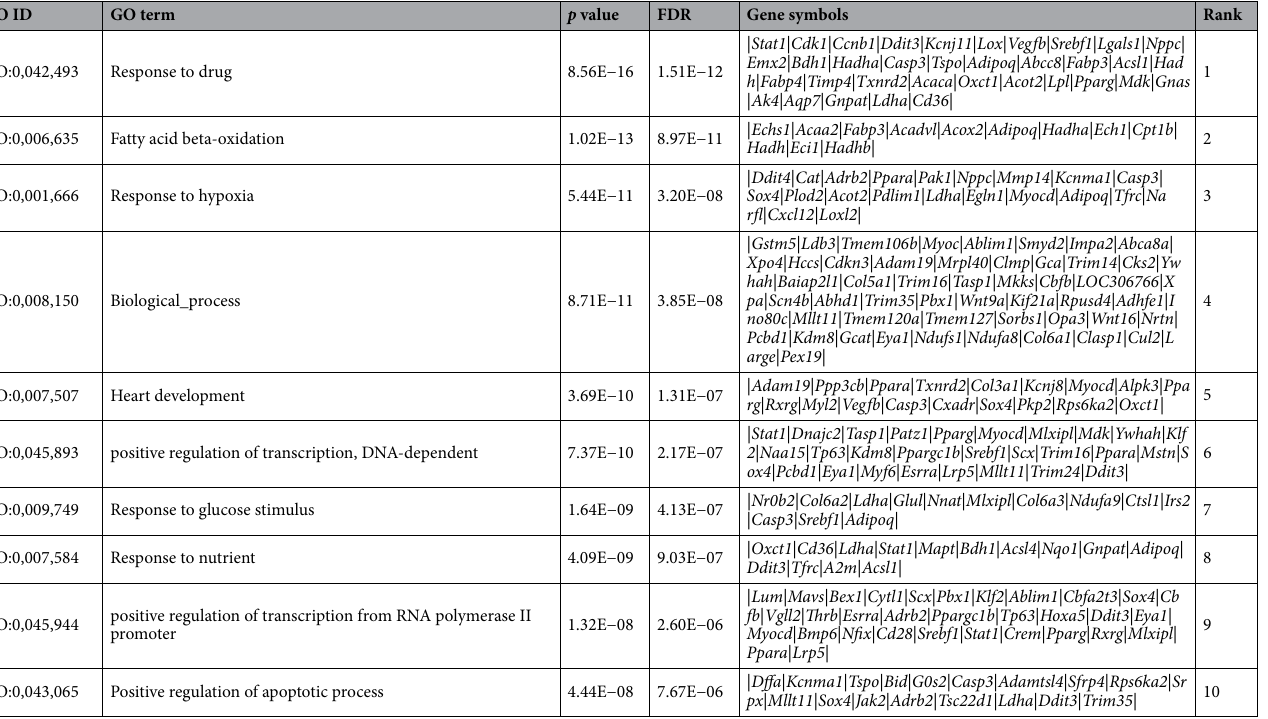
Table 2. Top 10 gene ontology (GO) terms with statistically significant enrichment (in the order of increasing p -value).